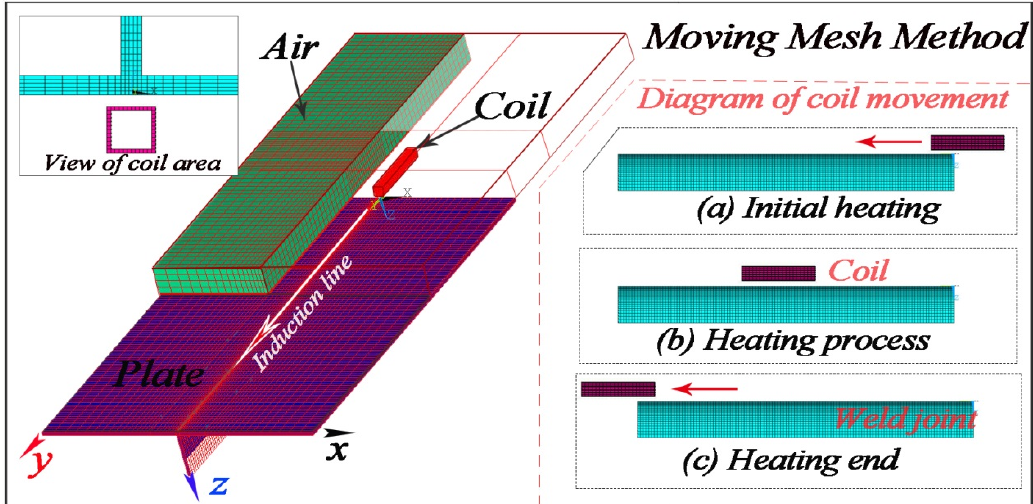
Figure 9. Simulation model based on moving mesh method.